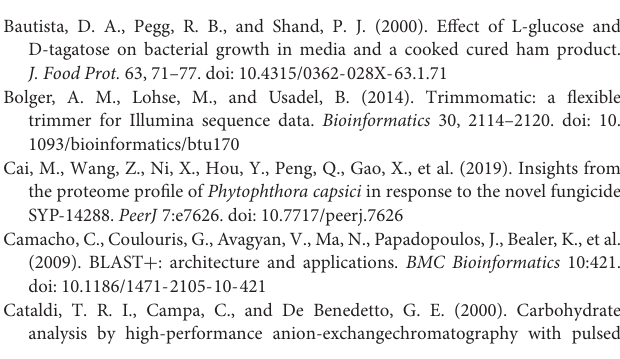
Supplementary Figure 5 | Correlation matrixes of P. infestans tagatose-incubated samples at 4 days after incubation. Supplementary Figure 6 | Correlation matrixes of P. infestans tagatose-incubated samples at 10 days after incubation. Supplementary Figure 7 | Correlation matrixes of P. cinnamomi control samples at 4 days after incubation. Supplementary Figure 8 | Correlation matrixes of P. cinnamomi control samples at 10 days after incubation. Supplementary Figure 9 | Correlation matrixes of P. cinnamomi tagatose-incubated samples at 4 days after incubation. Supplementary Figure 10 | Correlation matrixes of P. cinnamomi tagatose-incubated samples at 10 days after incubation. Supplementary Figure 11 | Principal component analysis (PCA) of Phytophthora spp. samples. Supplementary Figure 12 | Volcano Plot analysis for the identification of differentially expressed genes in Phytophthora spp. Supplementary Figure 13 | Venn diagrams of genes modulated by tagatose in Phytophthora spp. Supplementary Figure 14 | Correlation analysis of gene expression data assessed by RNA-Seq and quantitative real-time PCR. Supplementary Table 1 | Sugar content in the pea agar medium. Supplementary Table 2 | Primer sequences of the Phytophthora spp. genes analyzed by quantitative real-time PCR. Supplementary Table 3 | RNA-Seq sequencing and mapping results of each replicate. Supplementary Table 4 | Expression levels of Phytophthora infestans genes. Supplementary Table 5 | Expression levels of P. cinnamomi genes. Supplementary Table 6 | Pearson correlation values of P. infestans samples. Supplementary Table 7 | Pearson correlation values of P. cinnamomi samples. Supplementary Table 8 | Pearson correlation values of Phytophthora spp.